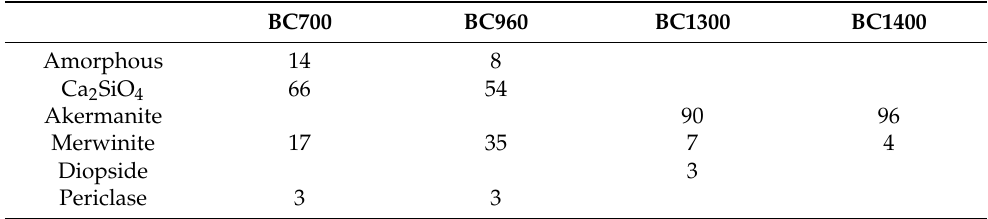
Table 6. Quantitative analysis of the XRD patterns in